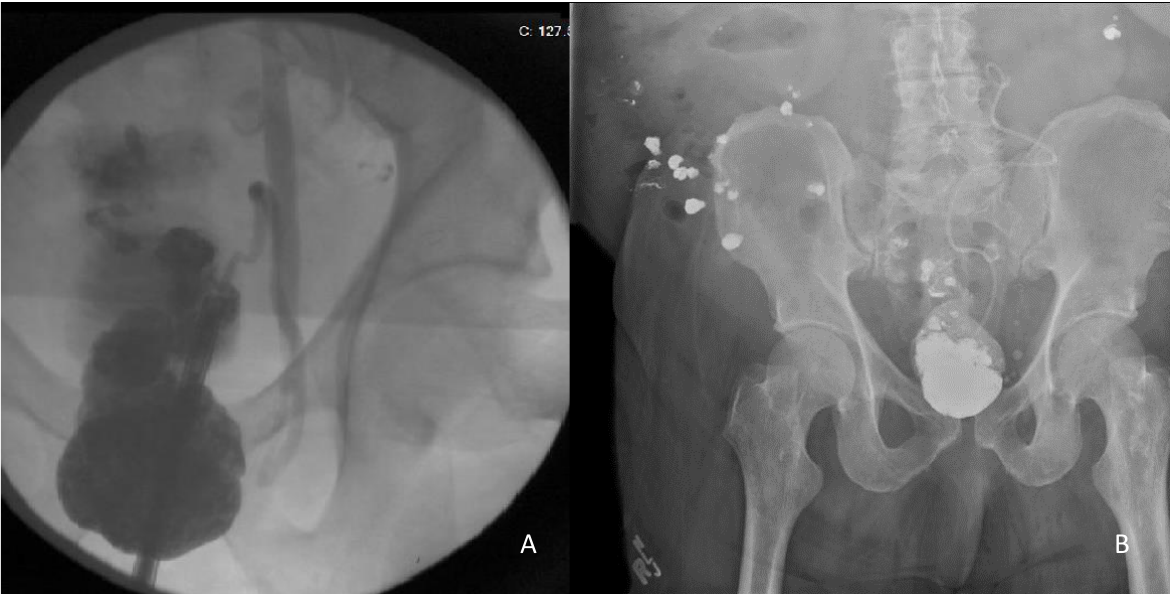
Figure 2. A: Retrograde pyelogram showing left ureter in the inguinal hernia sac. B: Postoperative abdominal X-ray showing redundancy of stented left ureter. 11), two patients (11.8%) had renal colic (8, 10) and one patient (5.9%) presented with incidental findings during workup for another ailment (4). In 15 (88.2%) of the cases, the ureter was identified in the hernia sac prior to operative intervention (1-6, 8-11). Three of these patients were primarily being worked up for uro- logic symptoms (4, 11), while 12 patients were being evaluated for large symptomatic inguinal hernias. In two patients (11.8%), ureteral involvement was not identified prior to surgical interven- tion for the hernia (1, 7). In one patient, the ureter was identified intra-operatively, reduced with the hernia contents and follow-up imaging revealed a normal upper urinary tract (7). In the second pa-